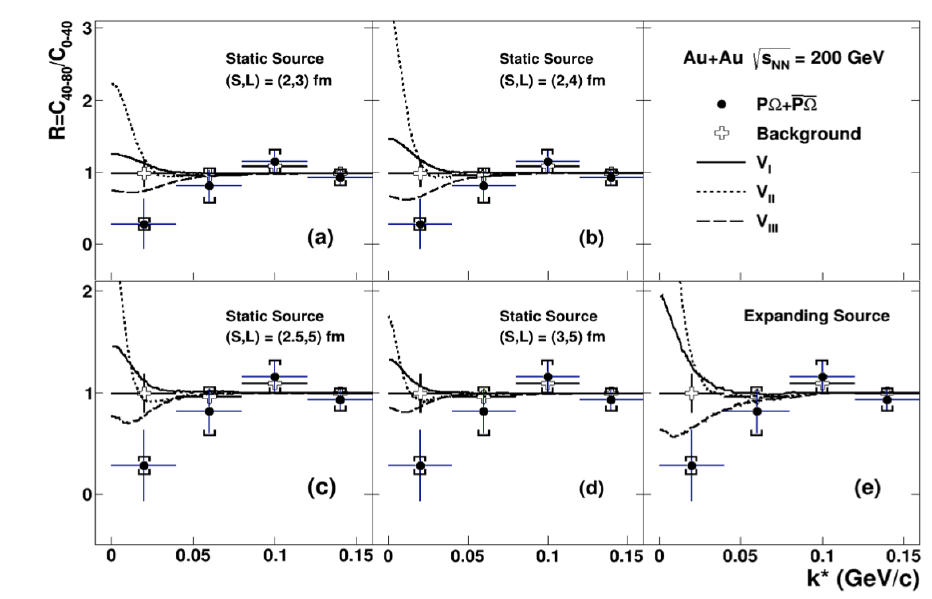
Figure 3. The solid circle represents the ratio (R) of the small system (40-80% collisions) to the large system (0-40% collisions) for proton-omega and ¯ p − Ω . The error bars correspond to the statistical errors, and caps correspond to systematic errors. The open crosses represent the ratio for background candidates from the side-band of omega invariant mass. Predictions for the ratio of the small system to the large system for p − Ω interaction potentials V I , V II and V III for static source with di ff erent source sizes (S, L) = (2,3), (2,4), (2.5, 5) and (3,5) fm, where S and L are corresponding to small and large systems, are shown in (a), (b), (c) and (d) respectively. In addition, the prediction for the expanding source is shown in (e)